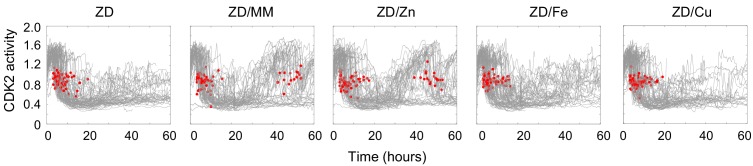
Zn2+ resupply, but not Cu2+ or Fe2+ allows for re-entry into the cell cycle following Zn2+ deficiency-induced quiescence.Single cell CDK2 traces of cells grown in ZD conditions (3 µM TPA) for 60 hr and cells grown in ZD for 21 hr and resupplied with either MM, ZnCl2 (0.73 µM), FeCl2 (0.8 µM), or CuCl2 (0.16 µM), (n = 80 random traces from four wells per condition for ZD, three wells for ZD/MM, and seven wells for ZD/Zn, ZD/Fe, and ZD/Cu). These concentrations were calculated from ICP-MS data on Chelex-treated MM. Specifically, because replacing half the medium on quiescent cells with MM induced cell cycle re-entry, we added back half the concentration of each element in MM. Red dots indicate mitosis events. Source Data Figure 1: Resting FRET values for cells grown in ZD, MM or ZR media for Figure 1A. Source Data Figure 1—figure supplement 1: ICP-MS data in ppb per cell for MM and Chelex-100-treated MM. Samples were run in triplicate. Source Data Figure 1—figure supplement 3: Live-dead analysis of cells grown in TPEN versus TPA. Source Data Figure 2—figure supplement 1: ICP-MS data in ppb per cell for cells grown for 24 hr in MM, MM + 2 μM TPA or MM + 3 μm TPA. Source Data Figure 3: CDK2 ratio over time for each track presented in Figure 3B. 321 tracks are presented for each condition. Each track contains 160 frames, where each frame is separated by 12 min. Source Data Figure 5: Quantification of DNA damage. Imaging parameters are presented for each cell in the analysis. Web Reference https://www.who.int/whr/2002/chapter4/en/index3.html. Last accessed July 3, 2019.